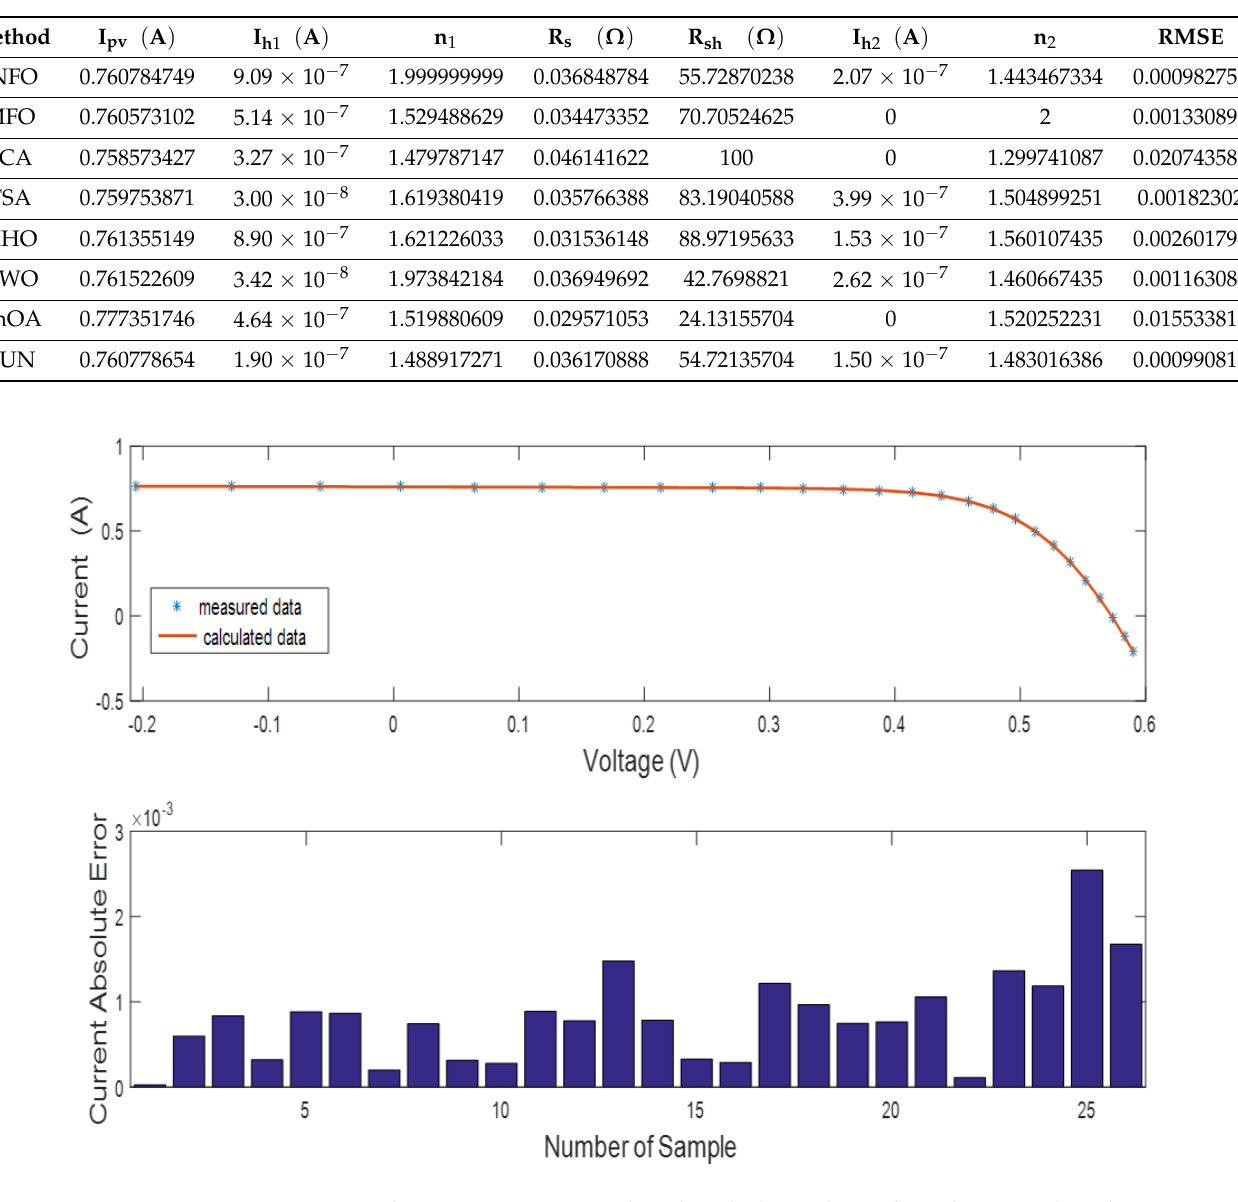
Figure 9. The DDMSC’s I–V curve based on the best solution from the INFO algorithm.